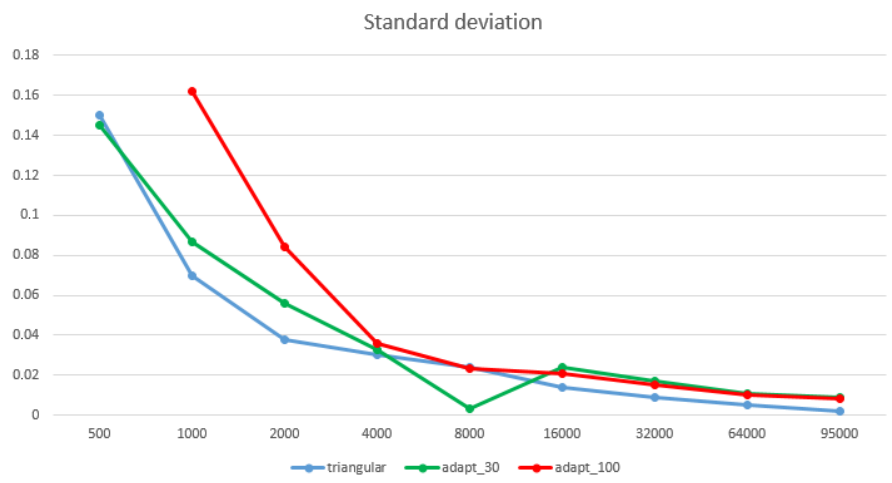
Figure 7. The standard deviation in mm of the simplified models for each simplification method compared to the high-resolution one. Expressed in a graph.